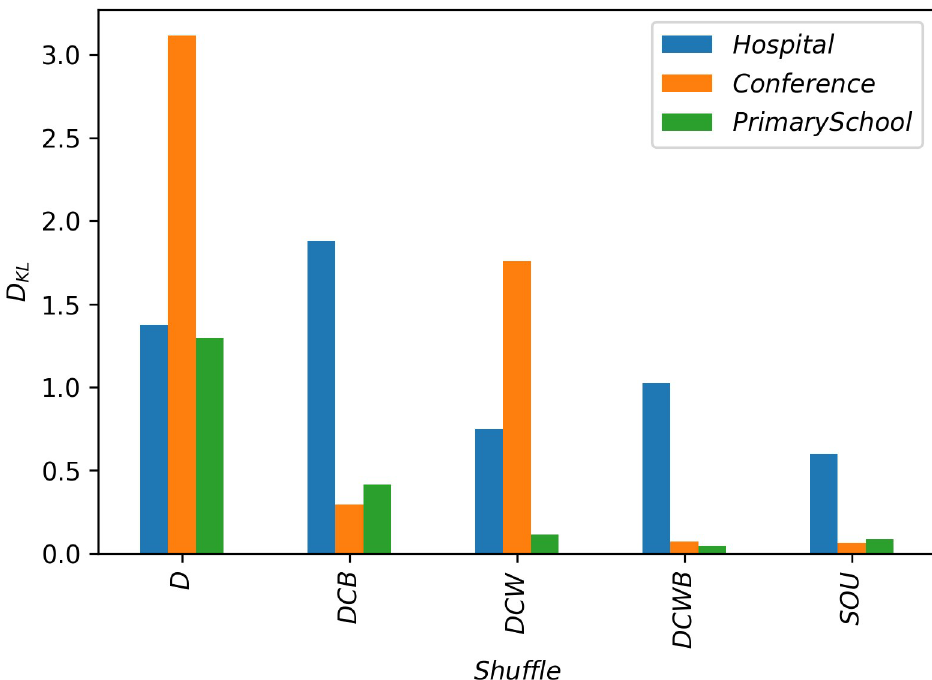
Fig 6. The value of cross-entropy for the dynamic results under each shuffle in relation to the original network for the value: p = 0.07 for hospital and conference networks and p = 0.005 for the primary school network. This parameter indicates the difference between the result of ρ distribution for coinfection ( q = 1) on each shuffled ab network and its original counterpart.